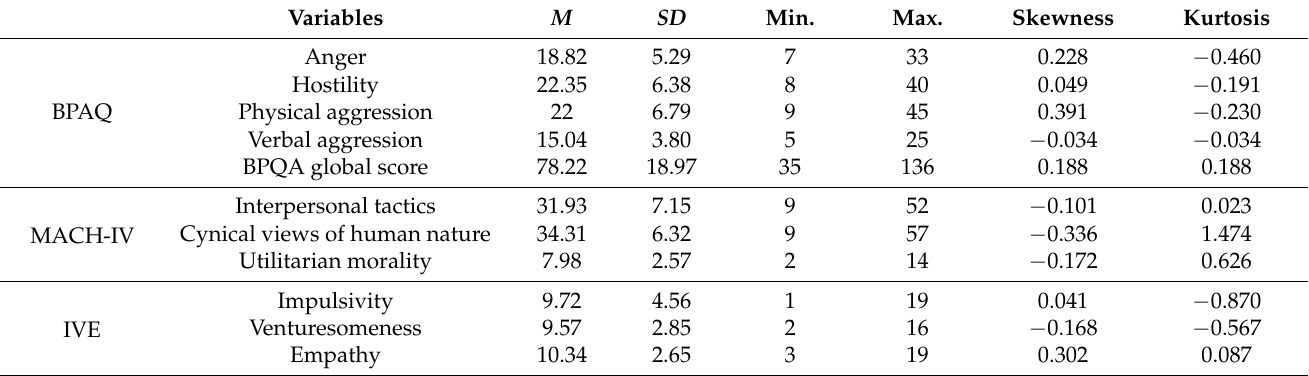
Table 3. Descriptive statistics for BPAQ, MACH-IV, and IVE for the prisoners